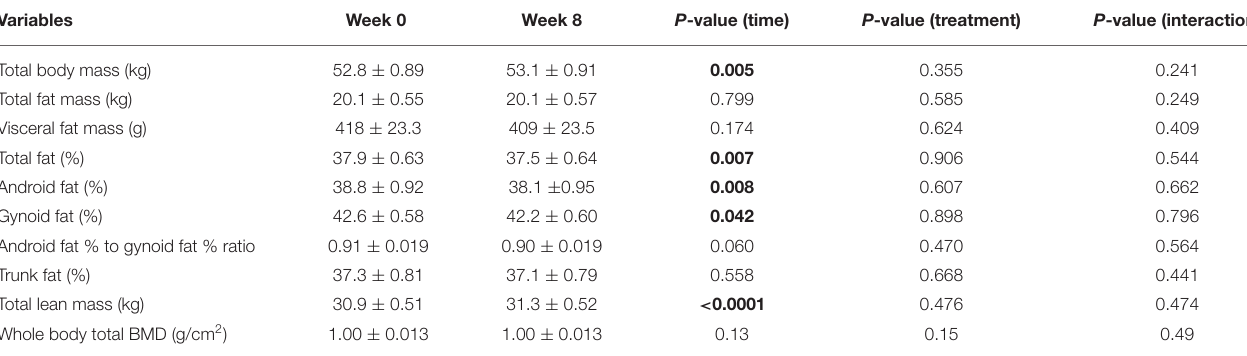
TABLE 4 | Baseline and end of intervention (week 8) body composition measurements obtained using DXA in